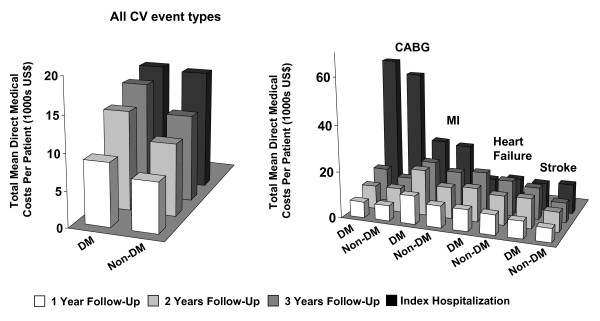
Total mean direct medical costs per patient over 3 years of follow up for all cardiovascular events (left-hand graph) and for selected cardiovascular event types (right-hand graph). CABG, coronary artery bypass graft; CV, cardiovascular; DM, diabetes mellitus; MI, myocardial infarction. Data provided represent the mean total cumulative direct medical costs per patient for cardiovascular events across 3 years of follow-up for all cardiovascular events and for selected event types.